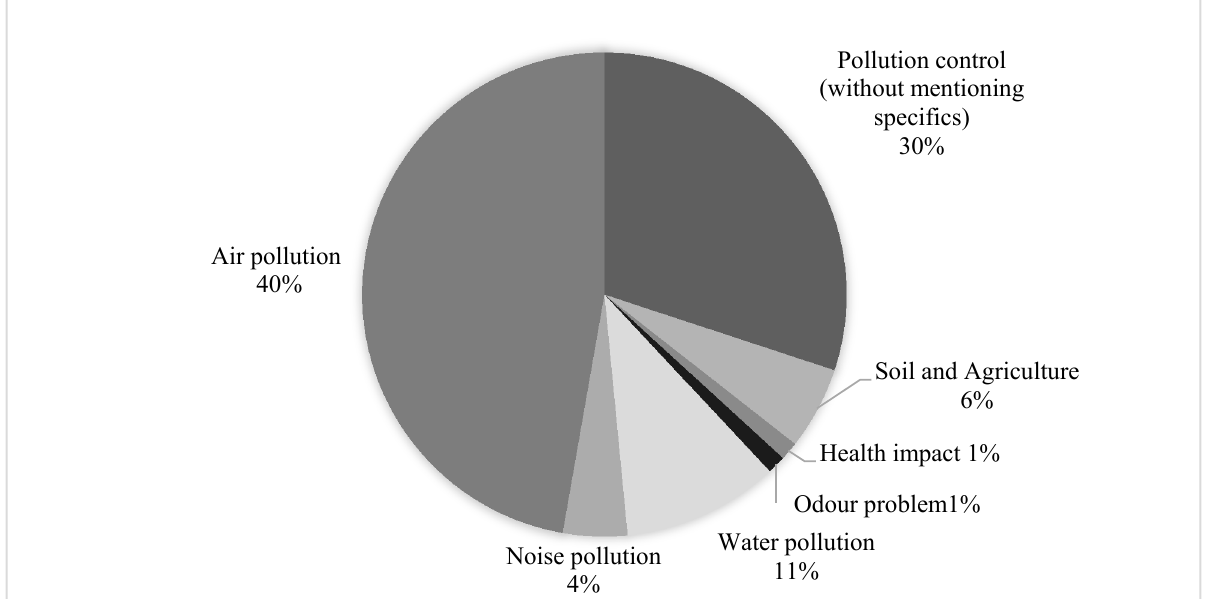
Figure 3. Pollution-related issues raised by people in 50 public hearings.